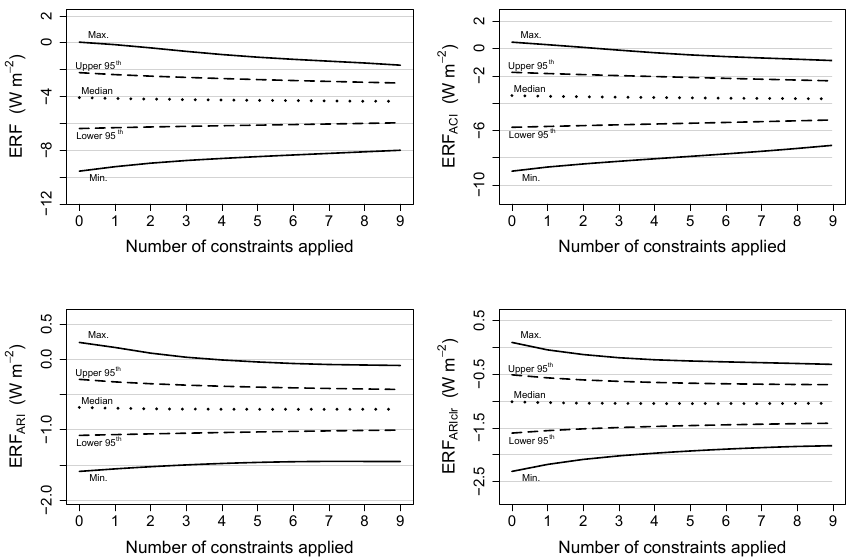
Figure 8. The dependence of July aerosol ERF uncertainty on the number of observational constraints applied. The lines show the mean effect of different numbers of